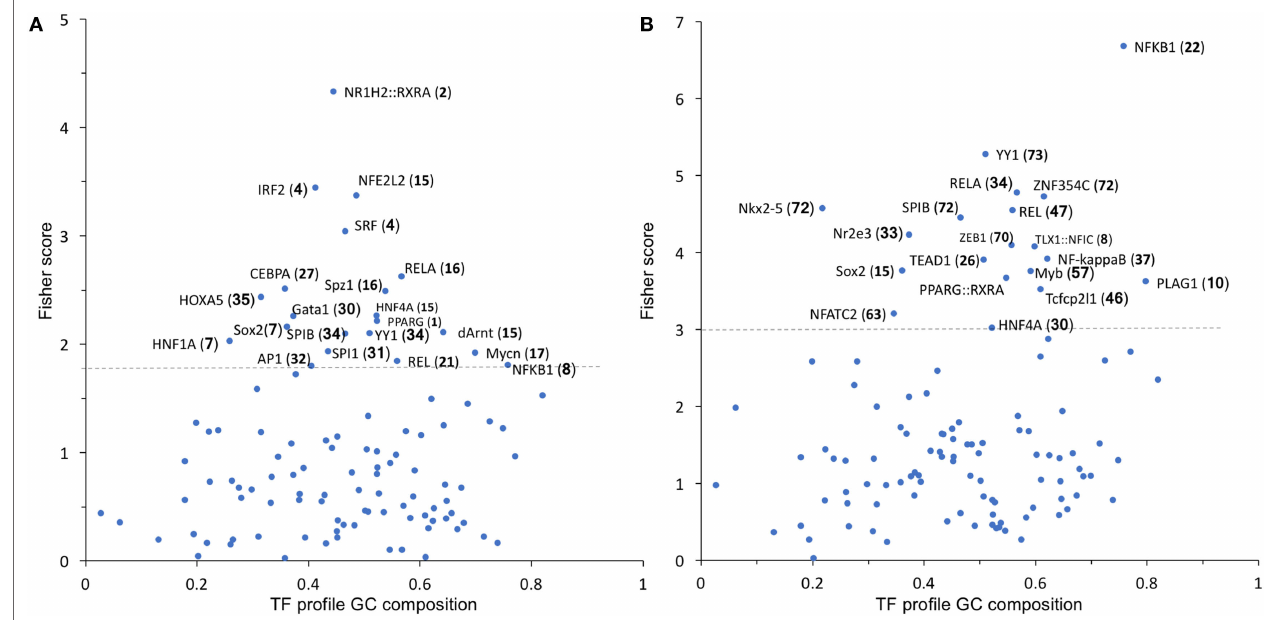
FigUre 5 | TF binding profile overrepresented in Group 1 (a) and Group 2 (B) transcripts, showing the Fisher score plotted against GC composition (1 = 100%). The threshold (dashed line) is set to the mean + 1 SD. The number in parentheses indicates the number of transcripts that map to each TF. TF, transcription